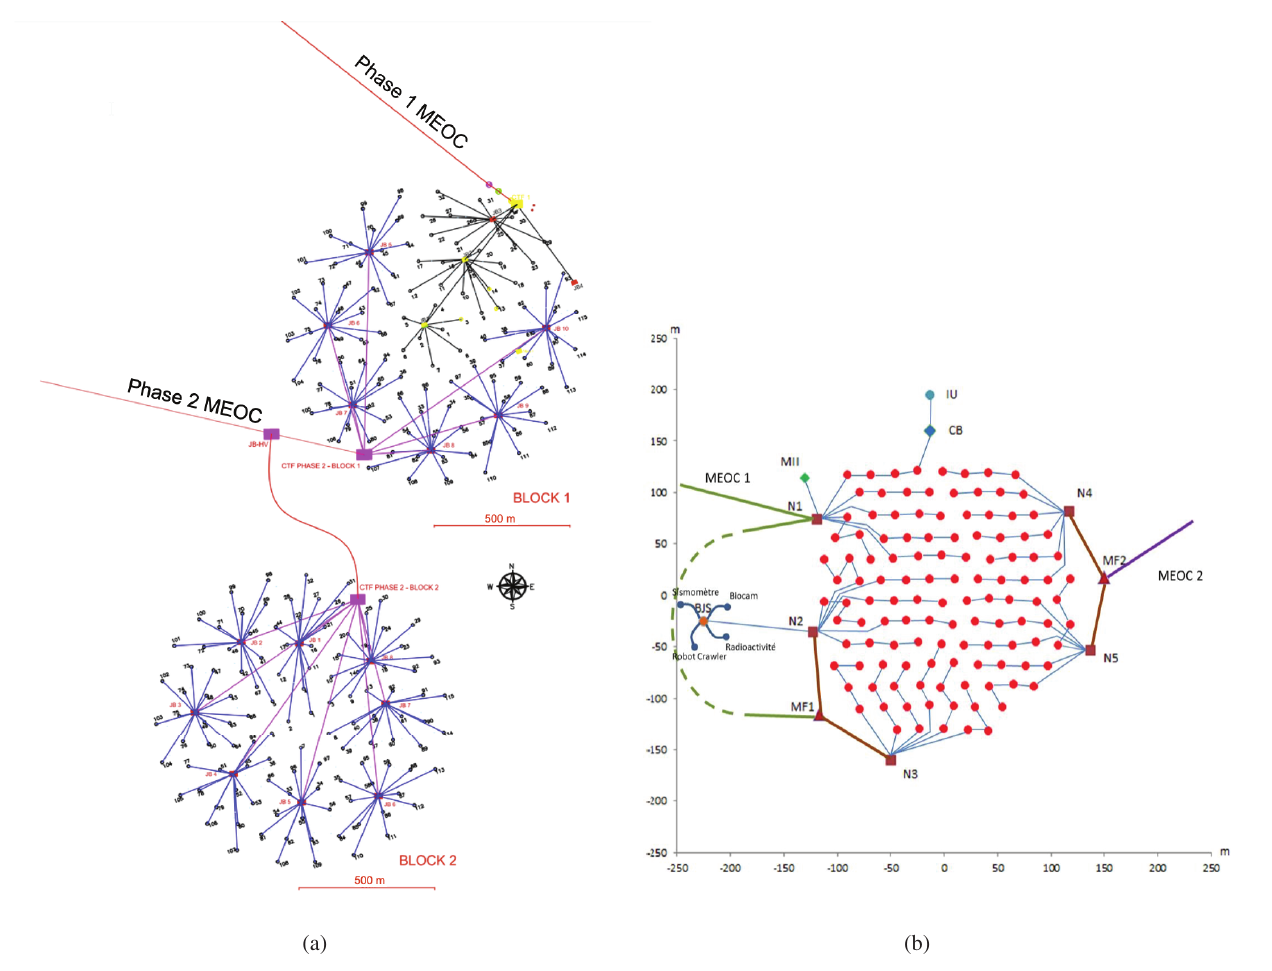
Figure 1: The ARCA (a) and ORCA (b) sea-floor maps. Each dot stands for a DU, while the straight lines indicate the inter-link cables connecting the DUs to intermediate stages of aggregation devices, up to the main electrical-optical cables (MEOCs). The aggregation designs of the DUs in the detector modules are di ff erent: ARCA follows a star-center approach, with groups of up to 14 DUs concentrated on devices called Junction Boxes (red squares); in ORCA, six daisy-chains made of 4 DUs each are concentrated on a device called Node (brown